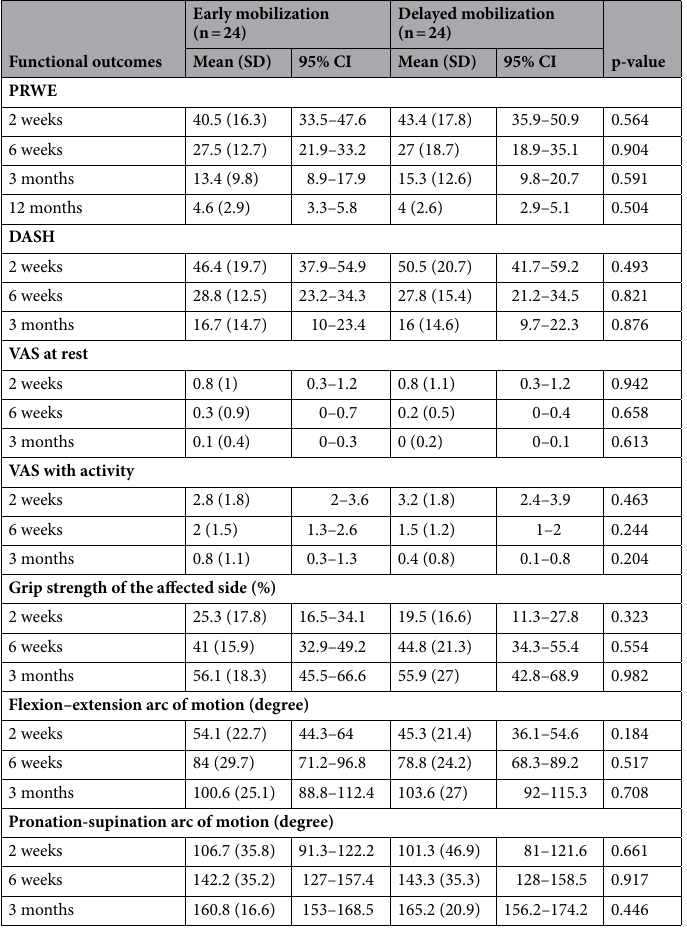
Table 2. Functional outcomes between the two groups at each follow-up period. Independent t-test. PRWE patient-rated wrist evaluation, DASH disabilities of arm, shoulder, and hand, VAS visual analog scale pain score.